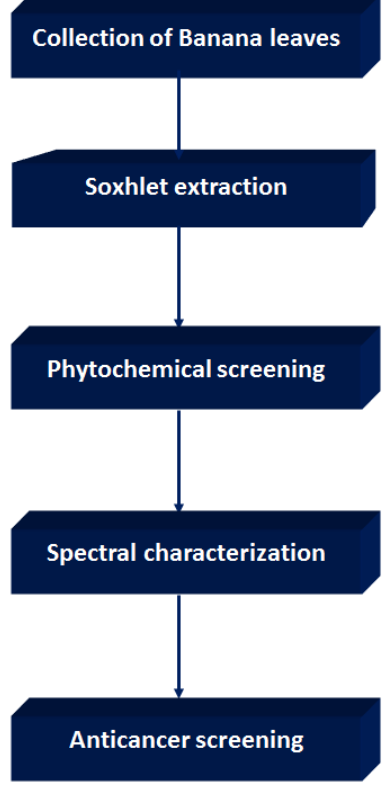
Fig. 2. Work plan of present